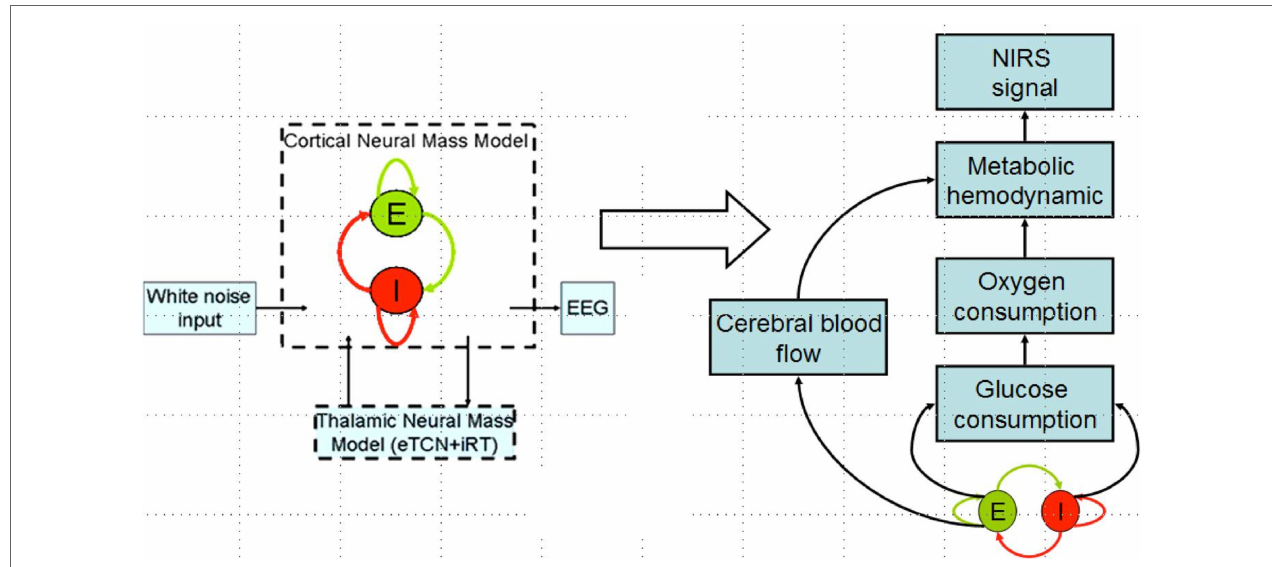
FiGUre 4 | Coupling hemodynamic response captured with nirs with neuronal response captured with eeG for the cortical neural mass jointly imaged with simultaneous nirs and eeG